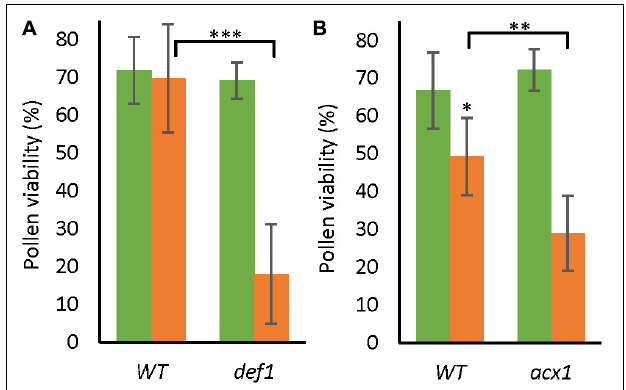
FIGURE 6 | Pollen viability of low-JA genotypes in CT and LTMH conditions. Pollen viability was measured 14–20 days after the onset of the treatment. Green bars represent CT, and orange bars LTMH treatment. (A) PV of def1 . LTMH consisted of repeated exposure to 30 ◦ C (day) and 24 ◦ C (night). Values indicate the mean ± SD ( n = 5 plants, with multiple pools of 3 anther cones per plant). Two-way ANOVA main effects: temperature P < 0.01; genotype P < 0.001; interaction P < 0.01. (B) PV of acx1 . LTMH consisted of repeated exposure to 31 ◦ C (day) and 25 ◦ C (night). Values indicate the mean ± SD ( n = 5 plants, with multiple pools of 3 anther cones per plant). Two-way ANOVA main effects: temperature P < 0.001; genotype ns; interaction P < 0.05. ∗ Significantly different between LTMH and CT in WT or between mutant and WT within temperature treatment (brackets), one-way ANOVA with LSD post hoc , P < 0.05; ∗∗ P < 0.01; ∗∗∗ P <